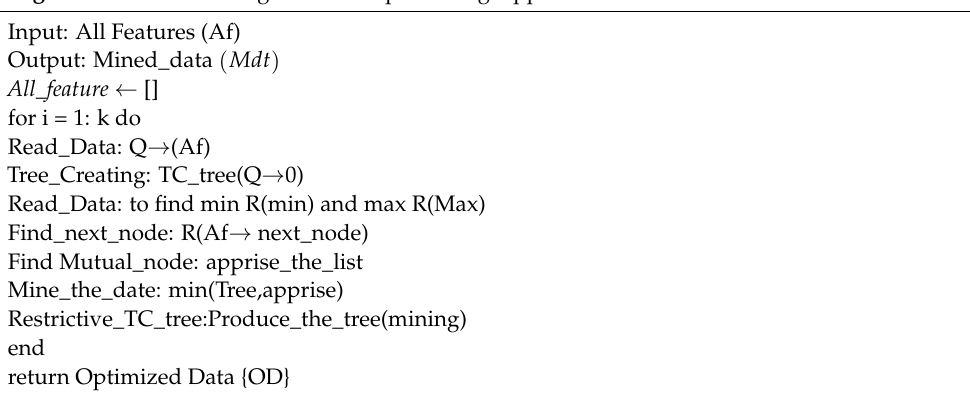
Algorithm 2. Data Mining via the Graph Mining Approach.